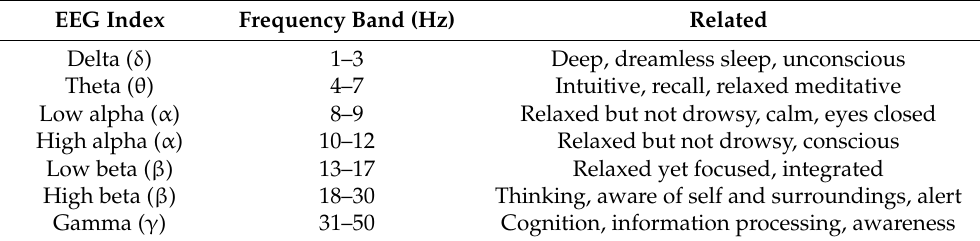
Table 3. EEG indexes and corresponding frequency bands and psychological states